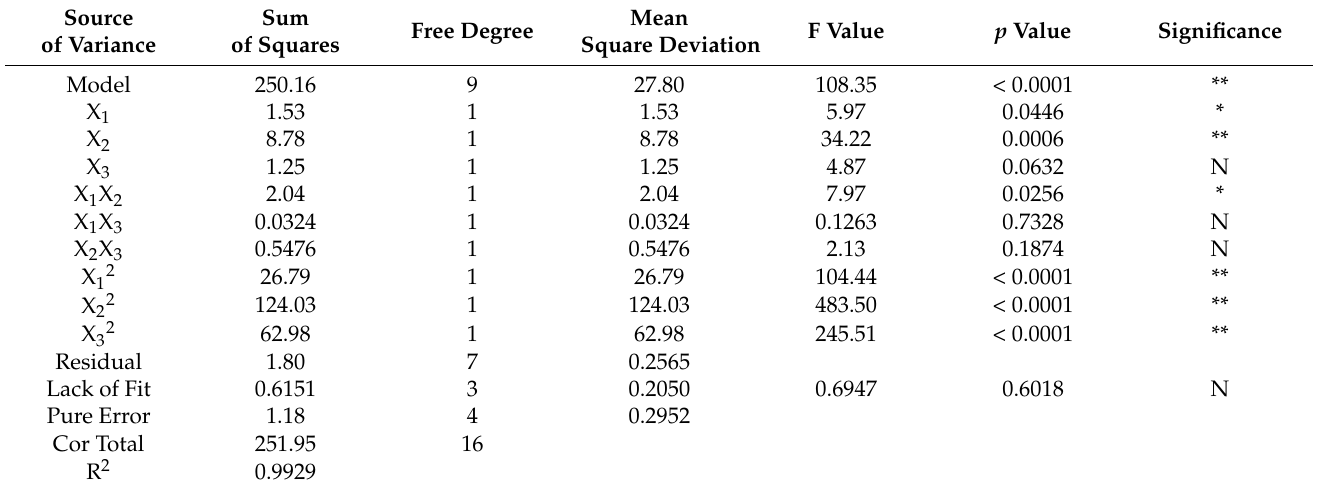
Table 5. Variance analysis of WBY polypeptide extraction rate.